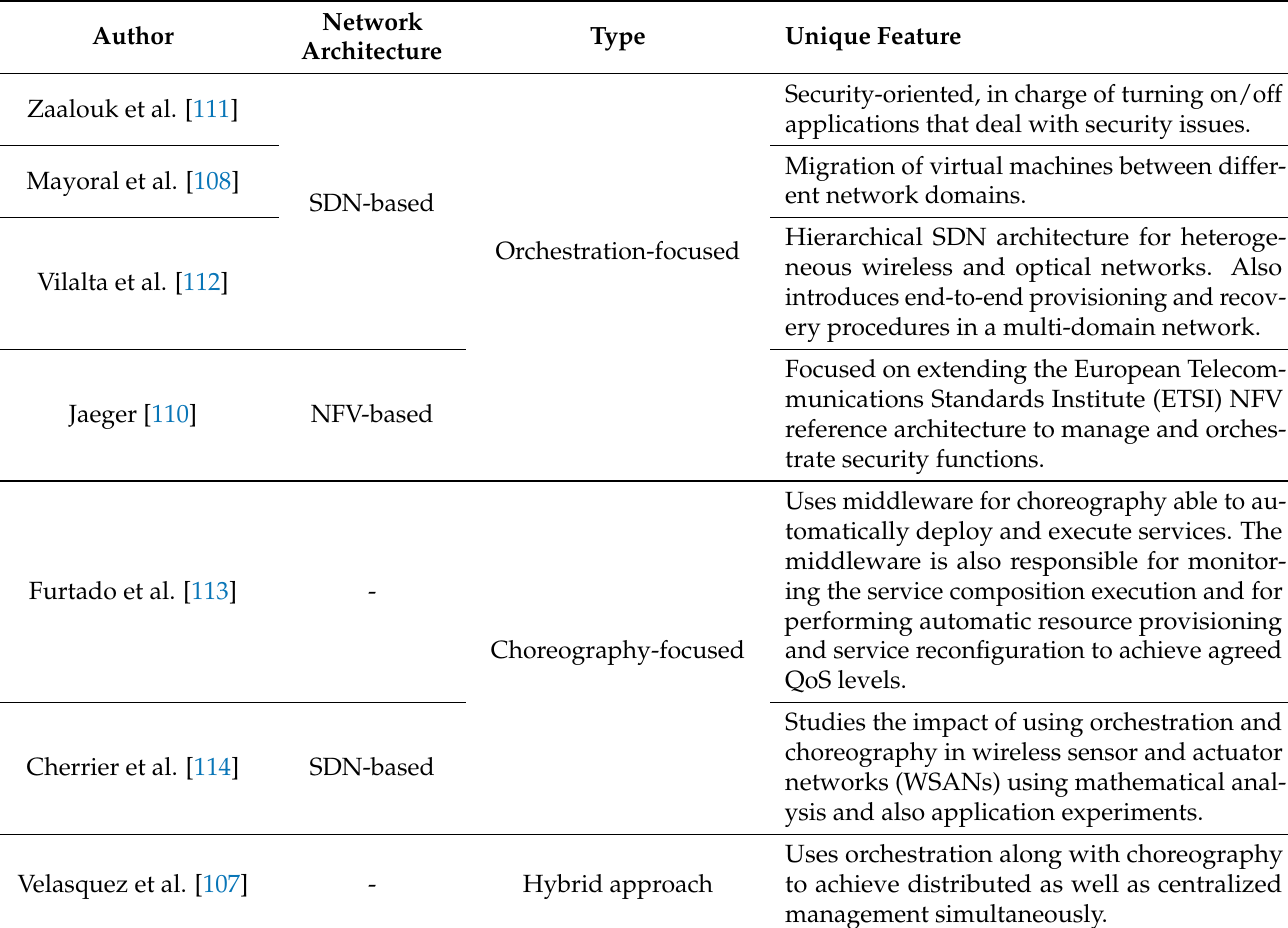
Table 4. Comparison of various works on